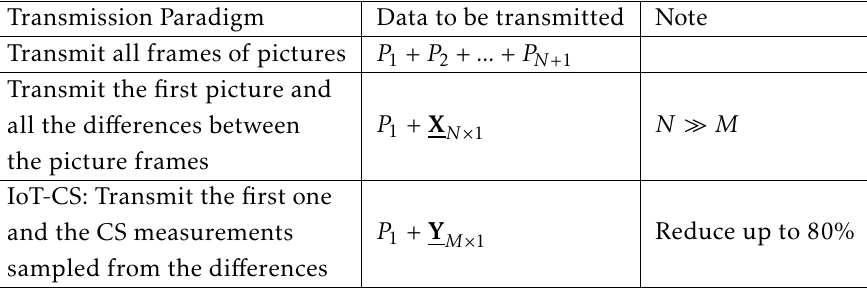
Table 1. Comparison table to show the benefit of using